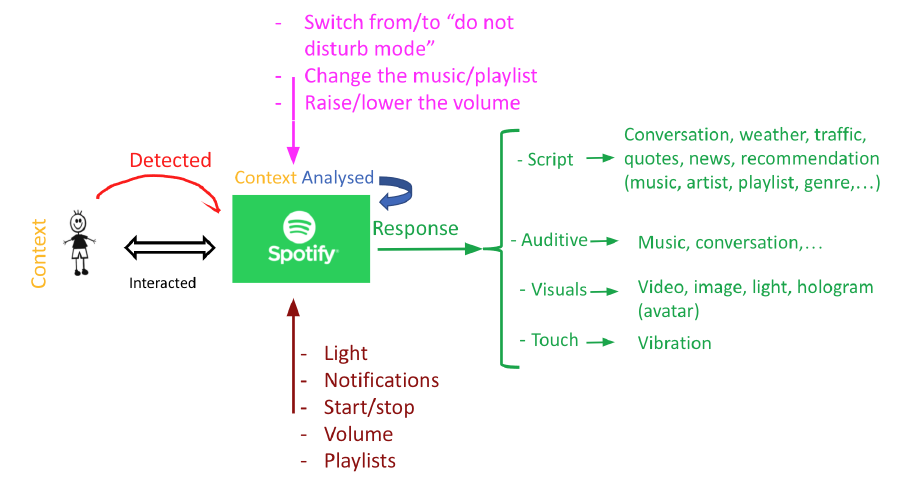
Figure 13. Example 3: